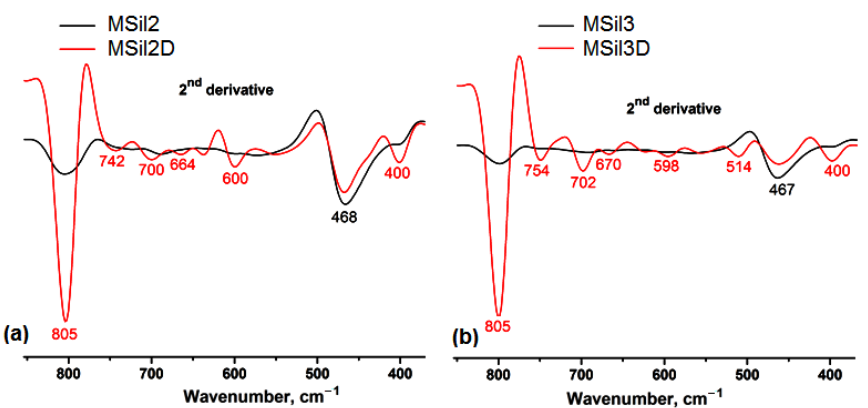
Figure 6. Second derivative of the IR spectra of Sil2, Sil 3 ( a ) and Sil2D, Sil3D, with Dox encapsulated ( b ) in the 850–400 cm − 1 spectral range.